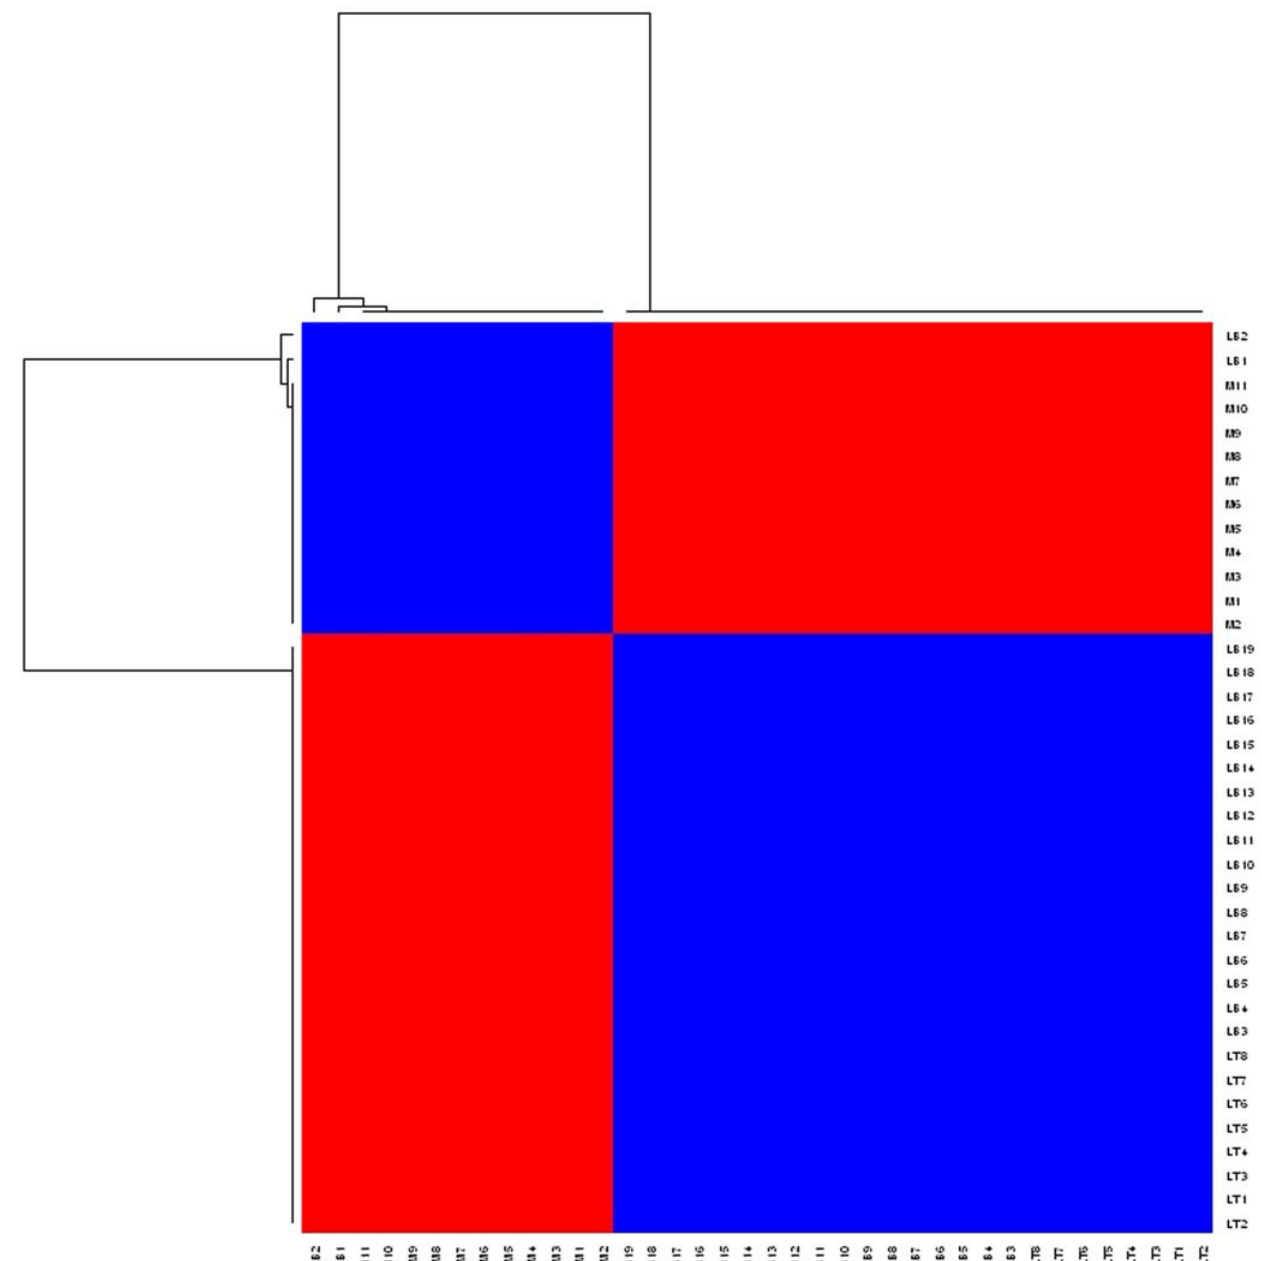
Figure 4. Heat map of re-ordered consensus matrix, k =2.